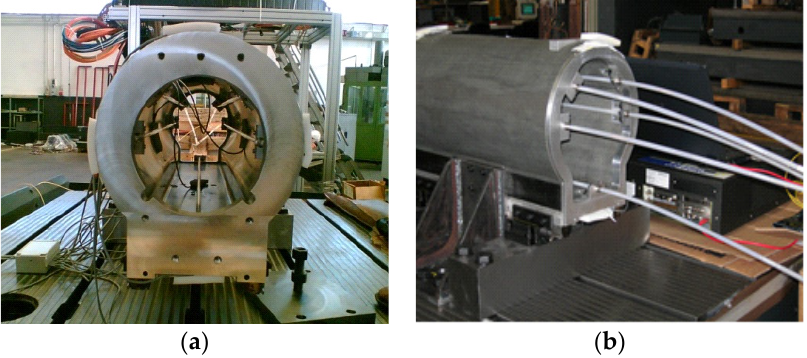
Figure 5. Test ‐ bench setup of the prototype with the embedded FBG sensors. ( a ) front side; Figure 5. Test-bench setup of the prototype with the embedded FBG sensors. ( a ) front side; ( b ) lateral view . ( b ) lateral